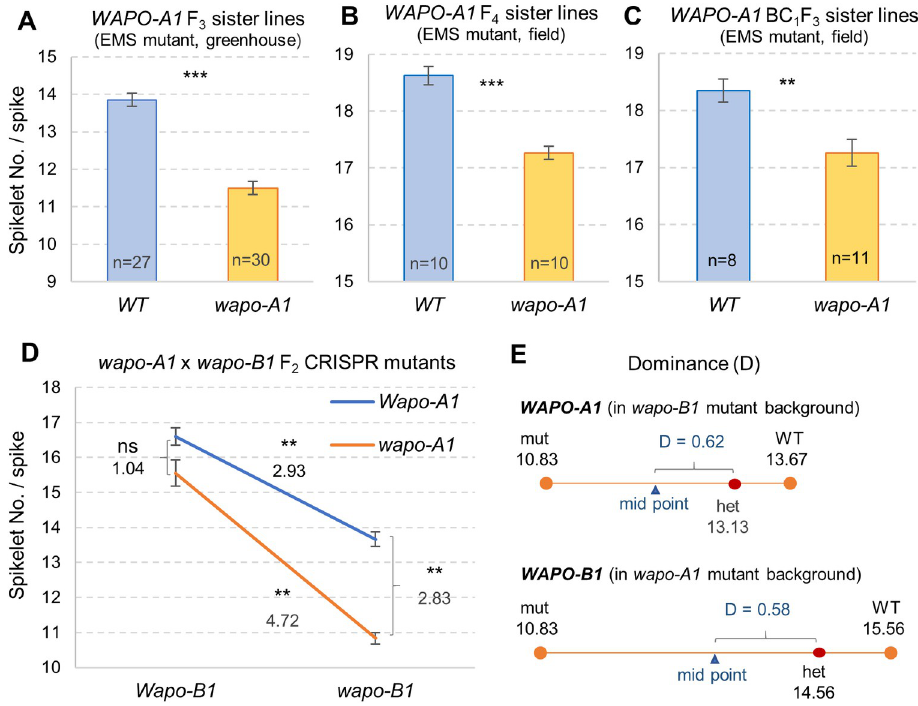
Fig 1. Differences in spikelet number per spike (SNS) in WAPO1 mutant lines. ( A-C ) Homozygous Kronos sister lines segregating for the EMS induced wapo-A1 W216 � mutation. ( A ) F 3 sister lines evaluated in the greenhouse. ( B ) F 4 sister lines evaluated in the field. ( C ) BC 1 F 3 sister lines evaluated in the field. ( D ) Loss-of-function CRISPR induced wapo-A1 and wapo-B1 mutations. Interaction graph showing the effect of wapo-A1 and wapo-B1 in tetraploid wheat Kronos plants without the CRISPR-Cas9 transgene. ( E ) Degree of dominance [17] for WAPO-A1 (in wapo-B1 background) and WAPO-B1 (in wapo-A1 background). Bars are average SNS and error bars are s.e.m. ns = not significant, � = P < 0.05, �� = P < 0.01 and ��� = P < 0.001. Data and statistical analyses used for this figure are available in Data A in S1 Data and panel A in S2